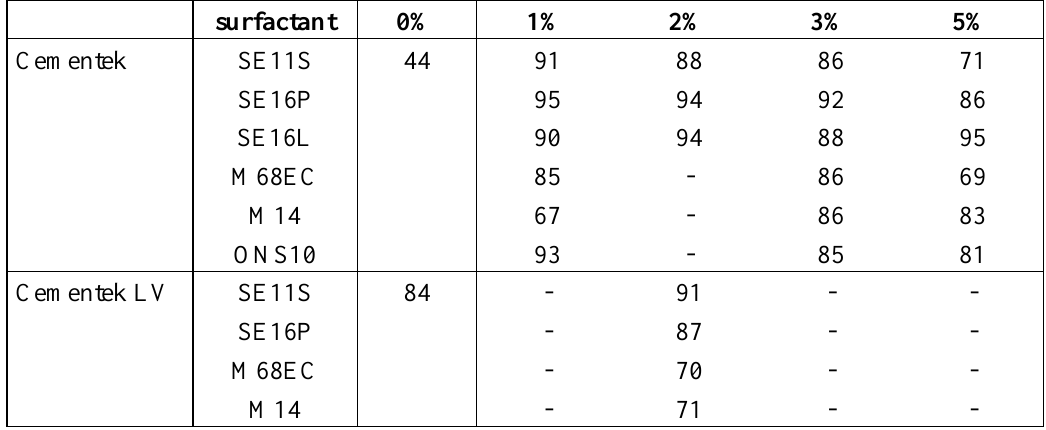
Table 1. Injectability of the Cementek and Cementek LV cement pastes (weight percent of cement extruded by